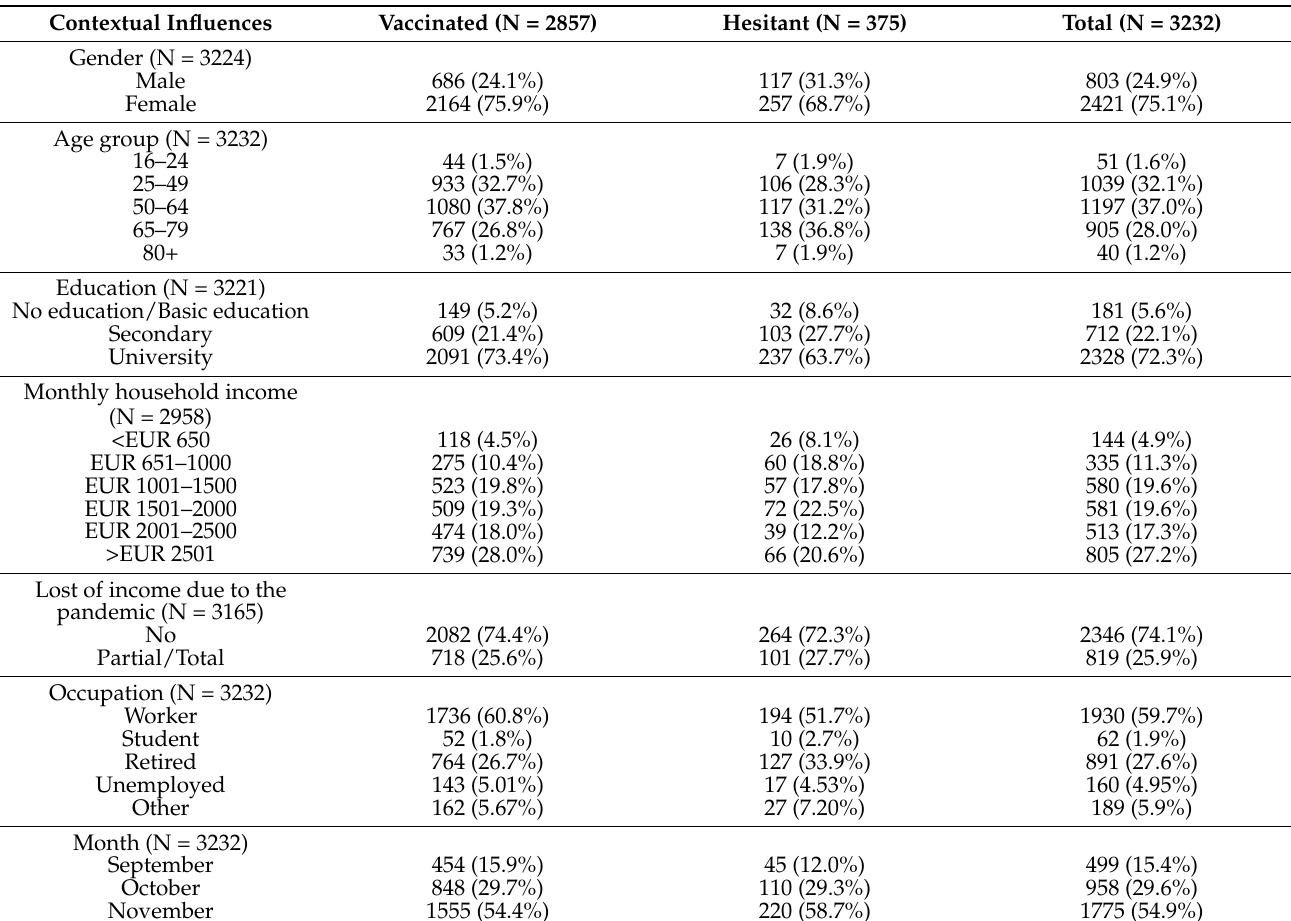
Table 2. Sample characteristics according to contextual influences.